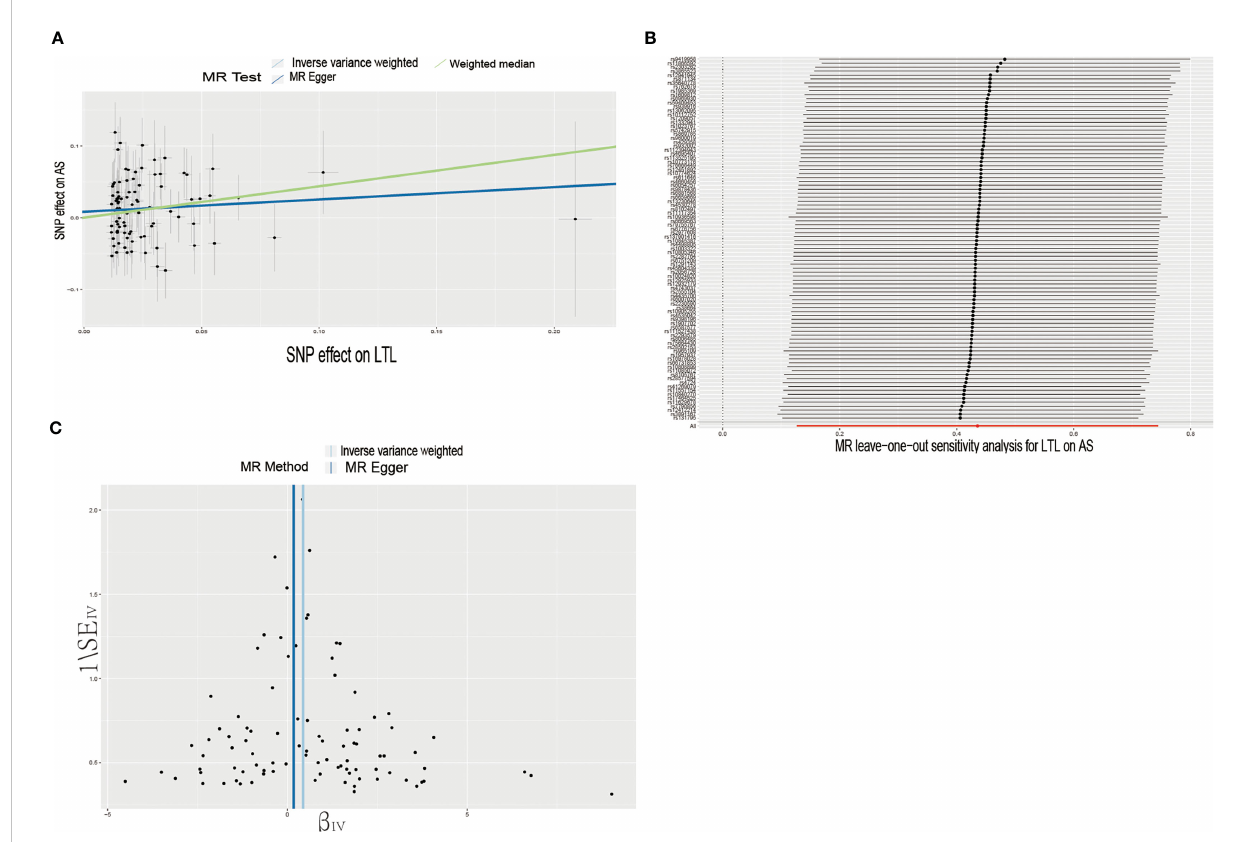
FIGURE 1 Causal effects of LTL on AS. (A) Scatter plot of the association between LTL and AS. This study used three methods to calculate the causal relationship between exposure factors and outcomes. The dark blue line represents MR Egger, the green line represents the weighted median, and the light blue line represents IVW. (B) Leave-one-out analysis to assess the effect of each SNP in driving causality. (C) Application of funnel plots to detect whether the observed associations are signi fi cantly heterogeneous. IVW, inverse variance weighting; LTL, leukocyte telomere length; AS, Ankylosing Spondylitis; MR, Mendelian randomization; SNP, single nucleotide polymorphism.